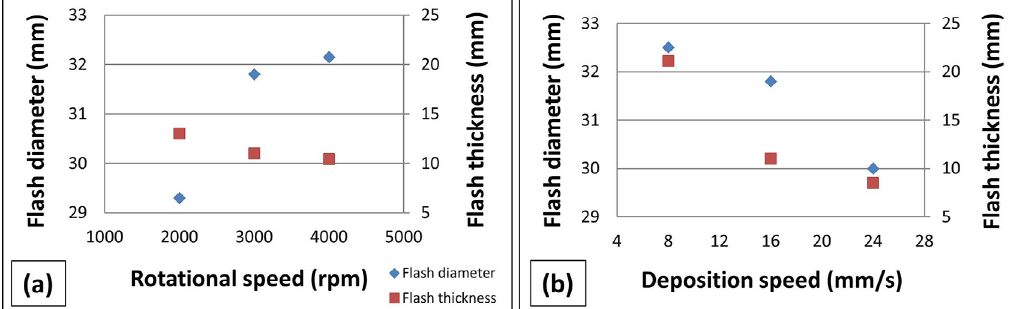
Figure 4. Effect of (a) rotational and (b) deposition speeds on the flash formed on the